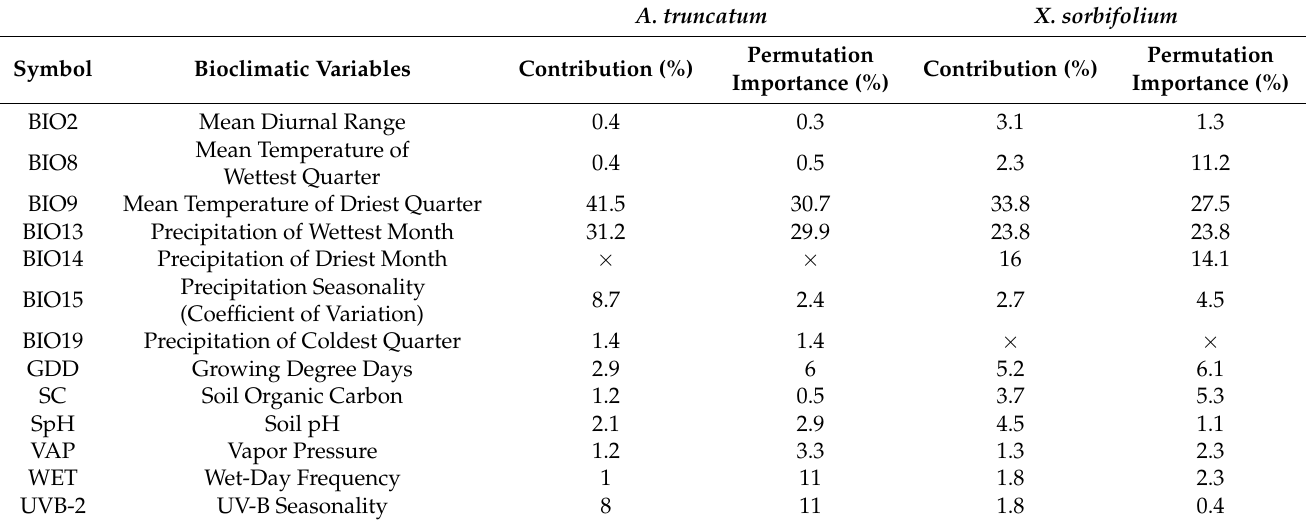
Table 1. Percentage contributions and permutation importance of the environmental variables in the Maxent models of A. truncatum and X. sorbifolium . Variables without any values (indicated by × ) were removed due to high cross-correlations. A. truncatum X.